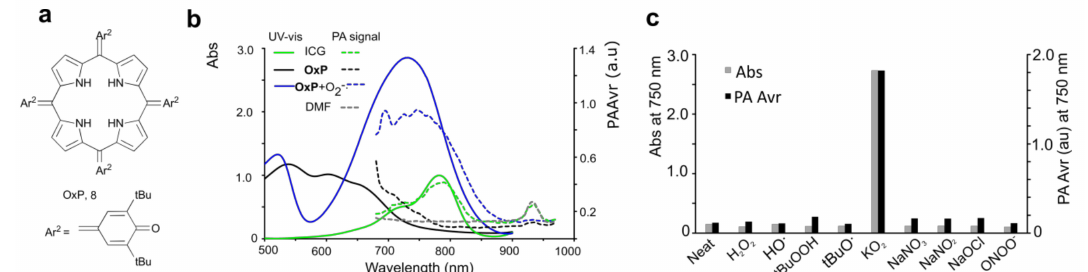
Figure 7. ( a ) The chemical structure of OxP ( 8 ), which traps O 2 − using the N H protons; ( b ) change in absorption and PA spectra of 8 upon trapping the O 2 − , and ( c ) selectivity of 8 towards a variety of reactive oxygen species (ROS) / reactive nitrogen species (RNS), quantified by UV-vis and PAI. Adapted with permission from Reference [86], Copyright: (2019) American Chemical